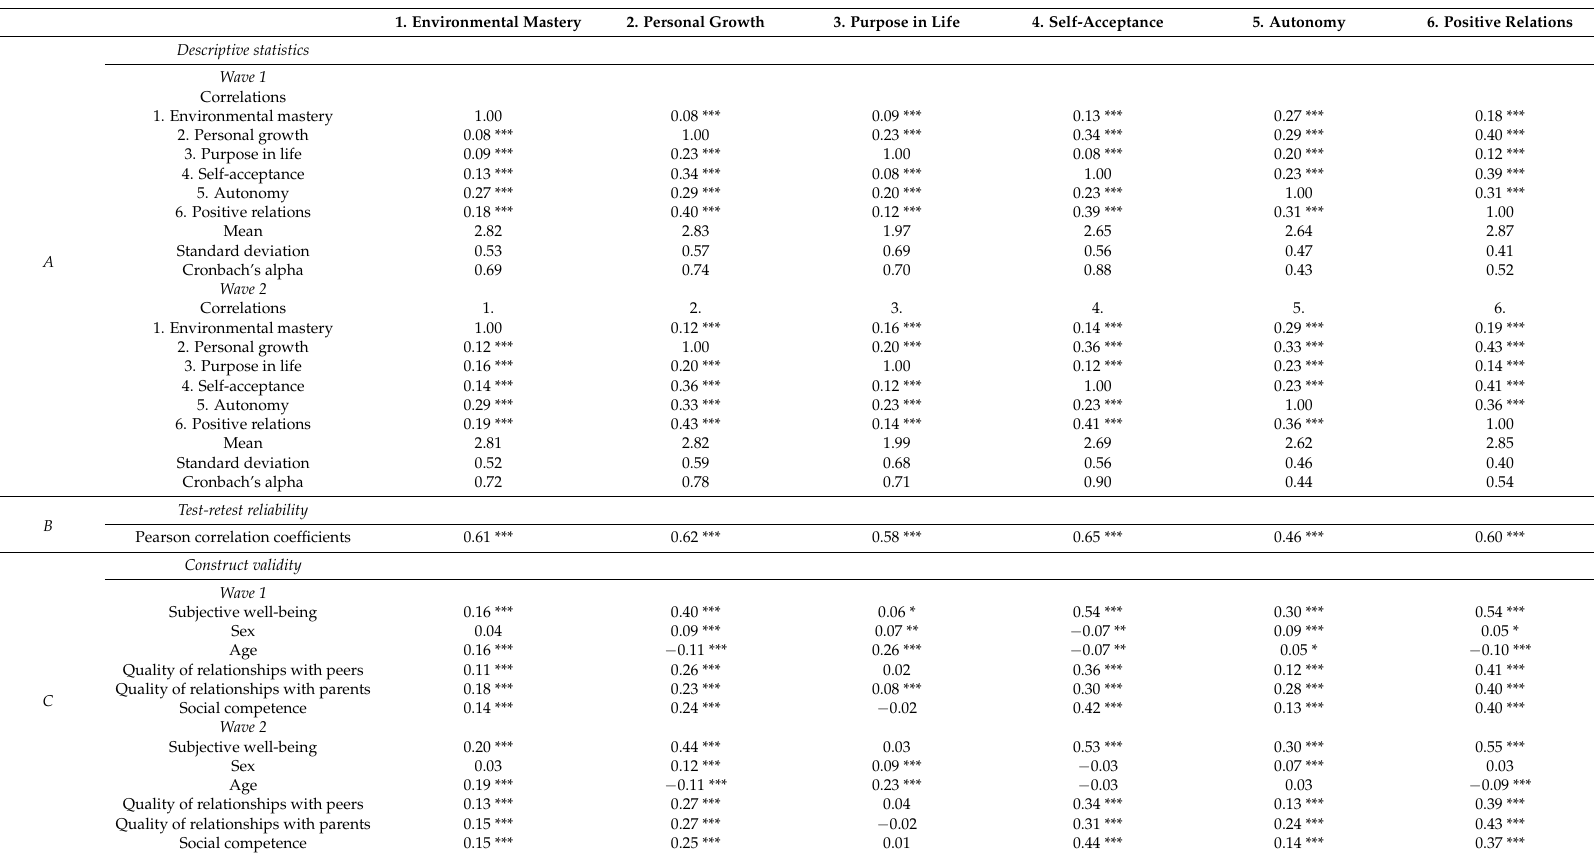
Table 4. Descriptive statistics, test-retest reliability, and construct validity for each dimension of psychological well-being scale for children (Main study, 24-item version, N =